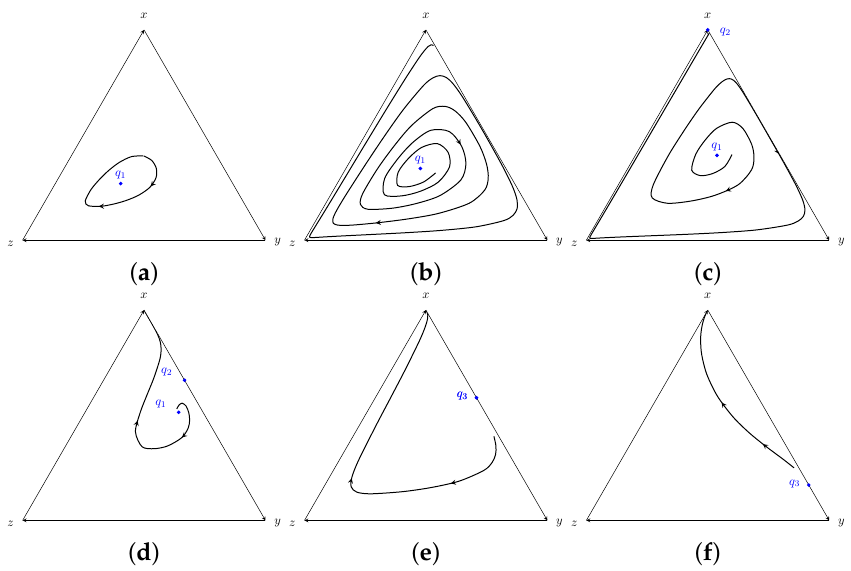
Figure 1. Phase diagram of the system when d increases. Parameters N = 5, r = 3, and σ = 1. For these values, d 1 = 0.16667 and d 2 = 0.2857. Notice that q 1 , q 2 , and q 3 are equilibrium points. ( a ) d = 0, ( b ) d = 0.1, ( c ) d = d 1 , ( d ) d = 0.25, ( e ) d = d 2 , and ( f ) d =